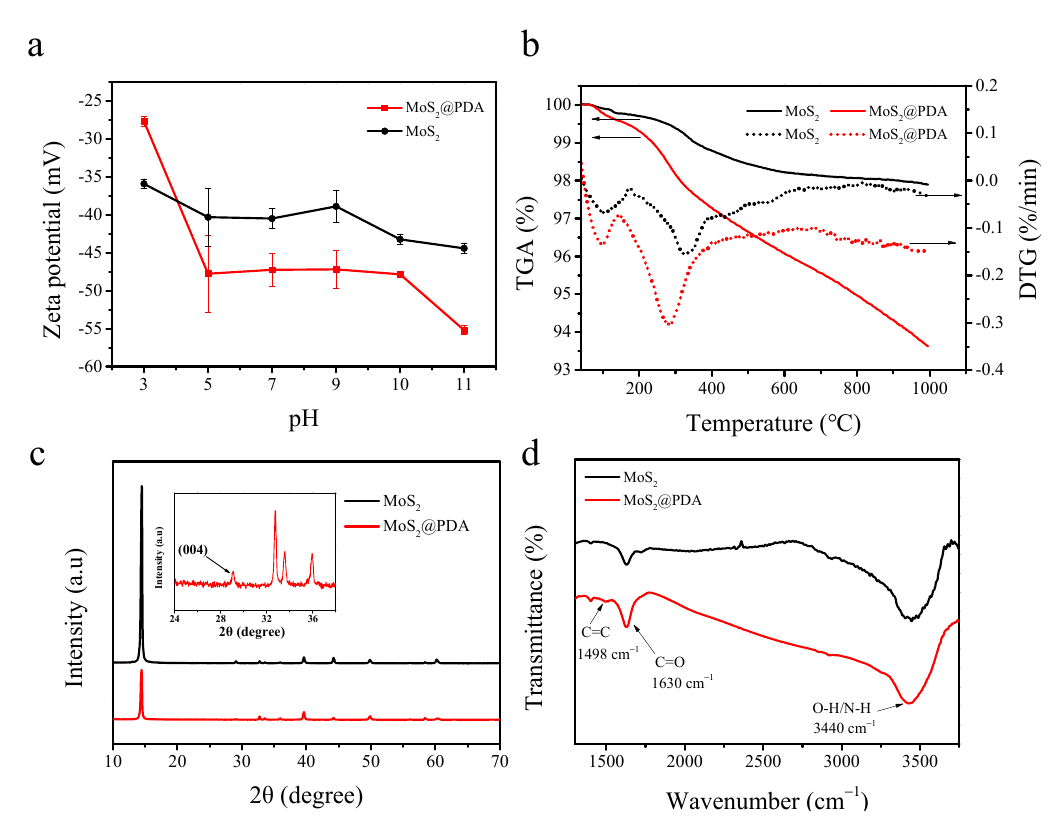
Figure 4. Zeta potential ( a ), Thermogravimetric analyses (TGA)-DTG curves ( b ), X-ray diffraction (XRD) characteristic ( c ), and Fourier transform infrared spectroscopy (FTIR) spectra of MoS 2 and MoS 2 @PDA ( d ).